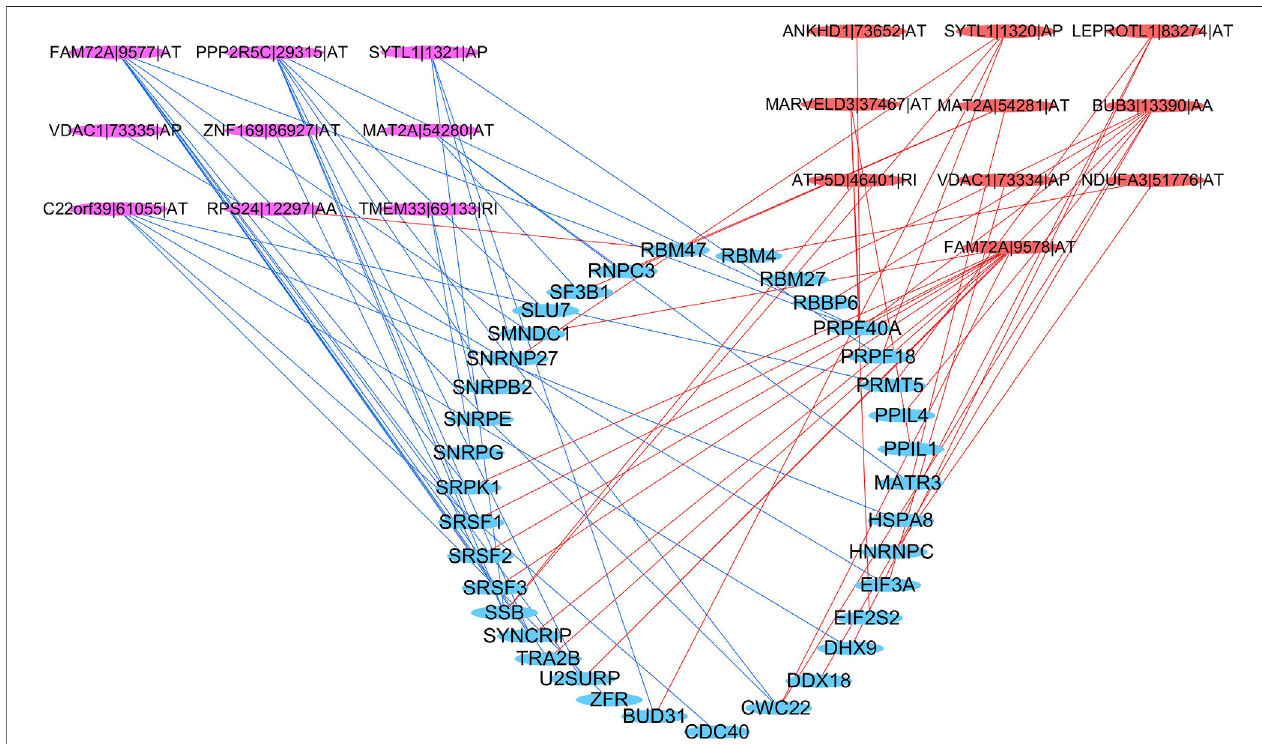
FIGURE10| RegulatorynetworkbetweenSFs andASevents.Blueellipse: splicedfactors, purple ellipse: low-riskASevents,red ellipse: high-risk ASevents,blue line: negative correlation, red line: a positive correlation.